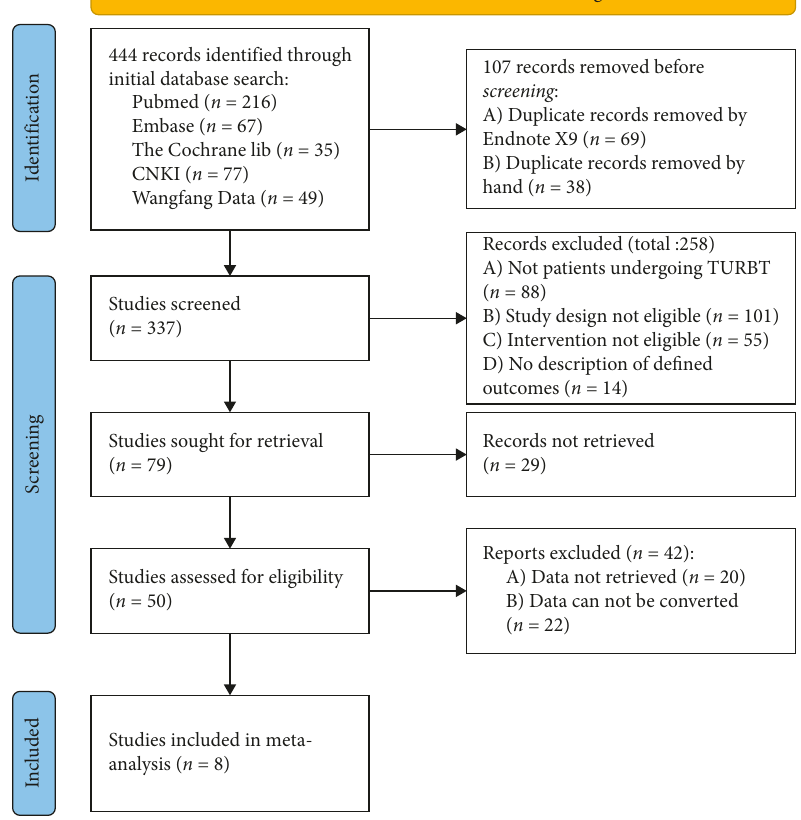
Figure 1: Literature selection flow chart.